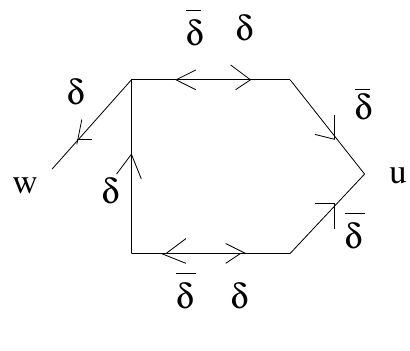
Figure 23 . Skeleton graph for (cid:8) 23 ;B (cid:0) 2(cid:8) 12 ;B